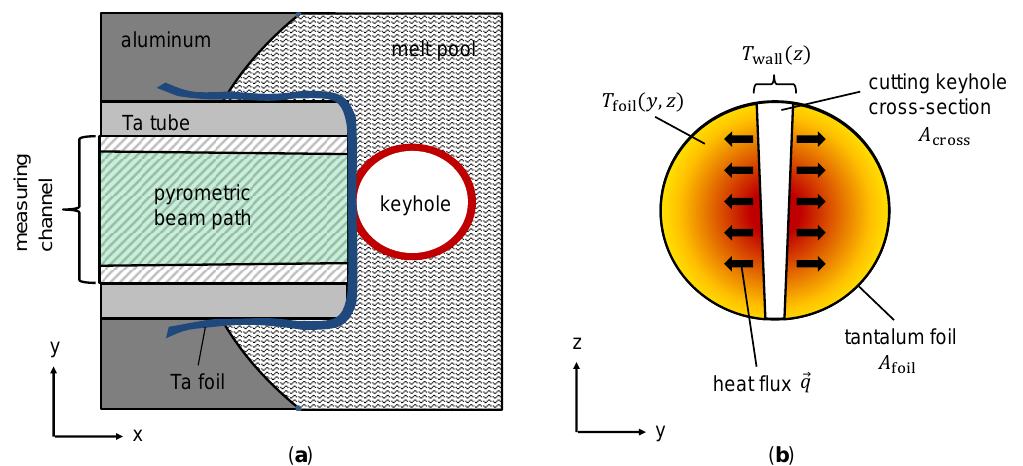
Figure 14. Geometric relation between keyhole and temperature screen: ( a ) view along the laser beam axis on the geometric intersection of the keyhole and the Ta foil, and ( b ) section between the keyhole and the temperature screen as seen by the pyrometer.